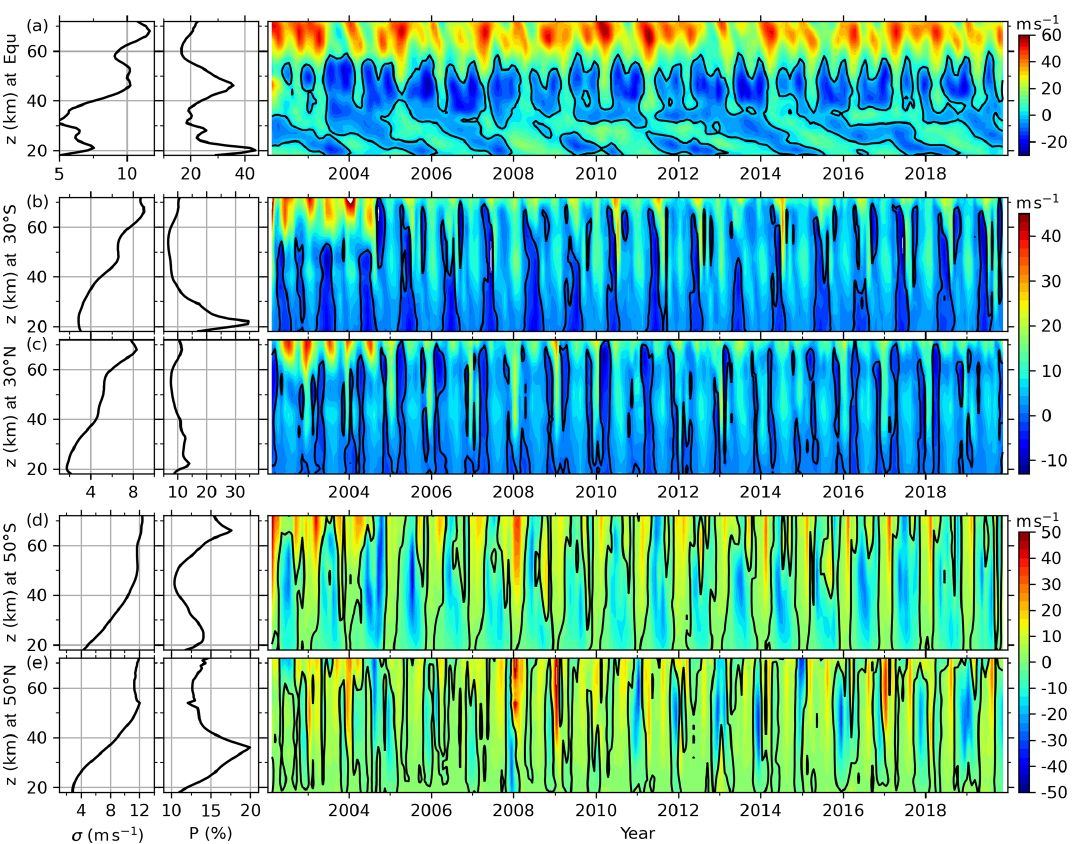
Figure 5. The wind differences between BU and MerU (right column) and their standard deviations ( σ , left column) and percentage differ- ences ( P , middle column) at the Equator (a) , 30 ◦ N/S (b, c) , and 50 ◦ N/S (d, e) . The black contour lines are the zero wind difference.